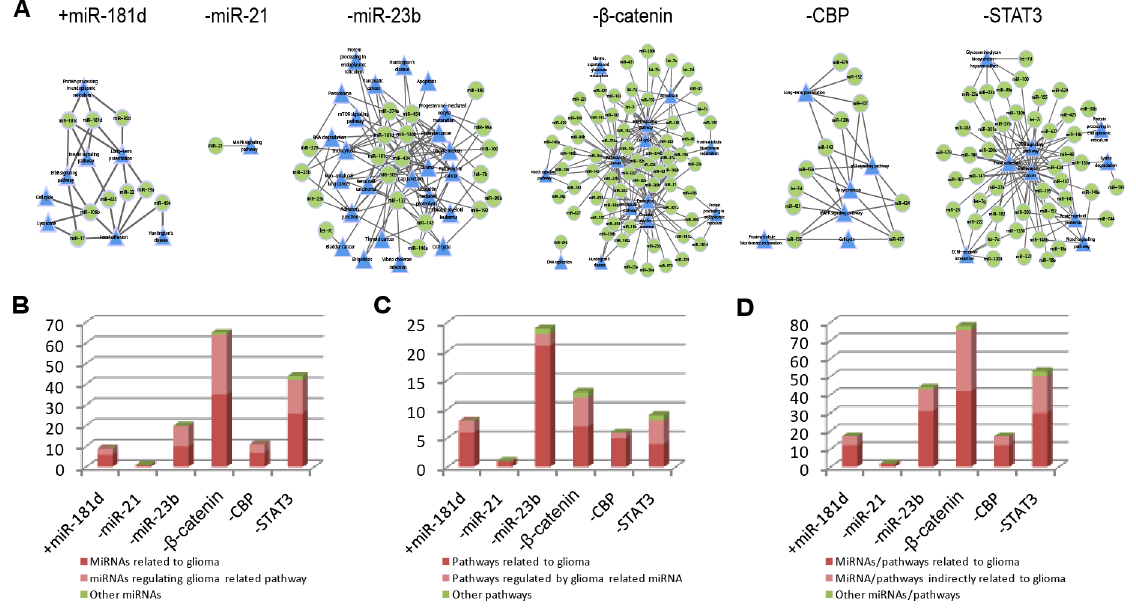
Figure 3. Global views of functional miRNA-pathway regulation networks (MPRNs). (A) Functional MRPNs resulting from each experimental manipulation. Green circles and blue triangles represent functional miRNAs and targeted pathways, respectively. The number and proportion of (B) miRNAs related to glioma and (C) pathways related to glioma in each MRPN, and (D) the overall proportion of miRNAs and pathways related to glioma in each MPRN are shown.